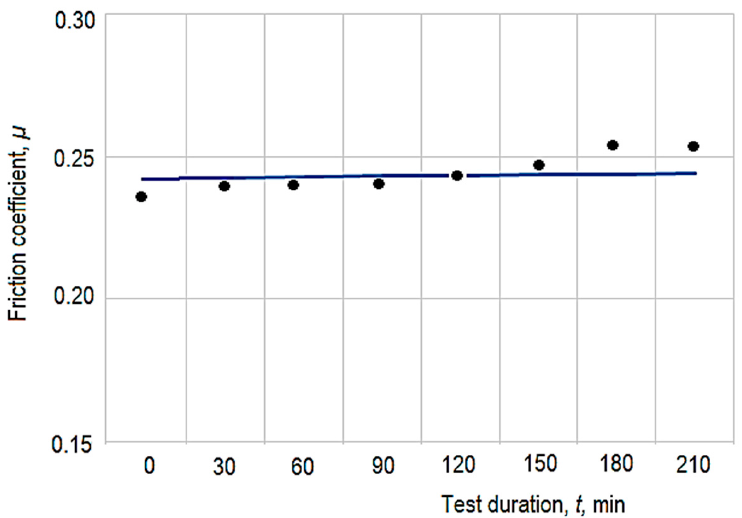
Figure 9. Testing the validity of the empirical mathematical model defined by Equation (6) ( p = 76,600 Pa).